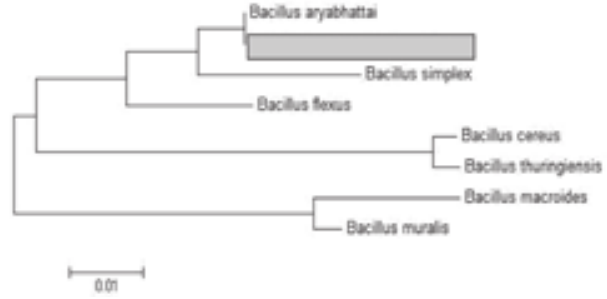
Fig. 4: The BLASTn analysis of Bacteria A4 basis on partial sequence showed 98% similarity to the Bacillus aryabhattai bacterial